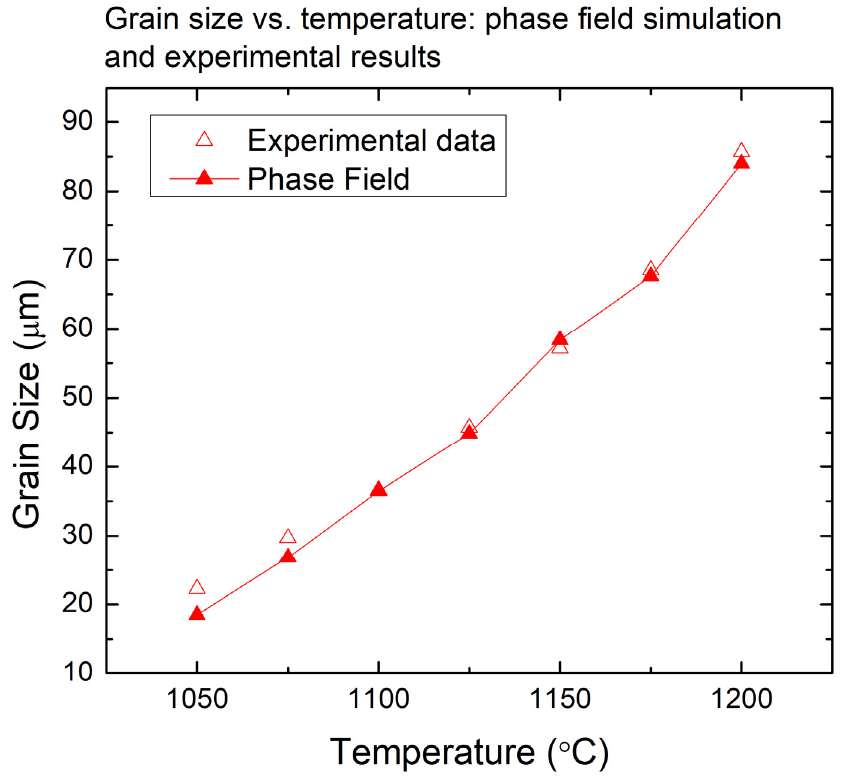
Figure 4. A comparison of the phase field calculation results of the grain size in the continuously heated alloy with the experimental data from Brun et al. [35] shows that the heating rate is 25 °C/s.